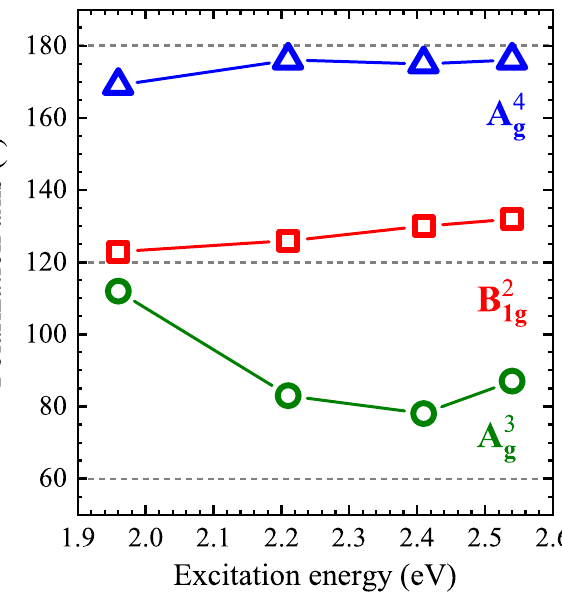
Figure 7. The effect of the excitation energy on the polarization axes of three phonon modes: B 2